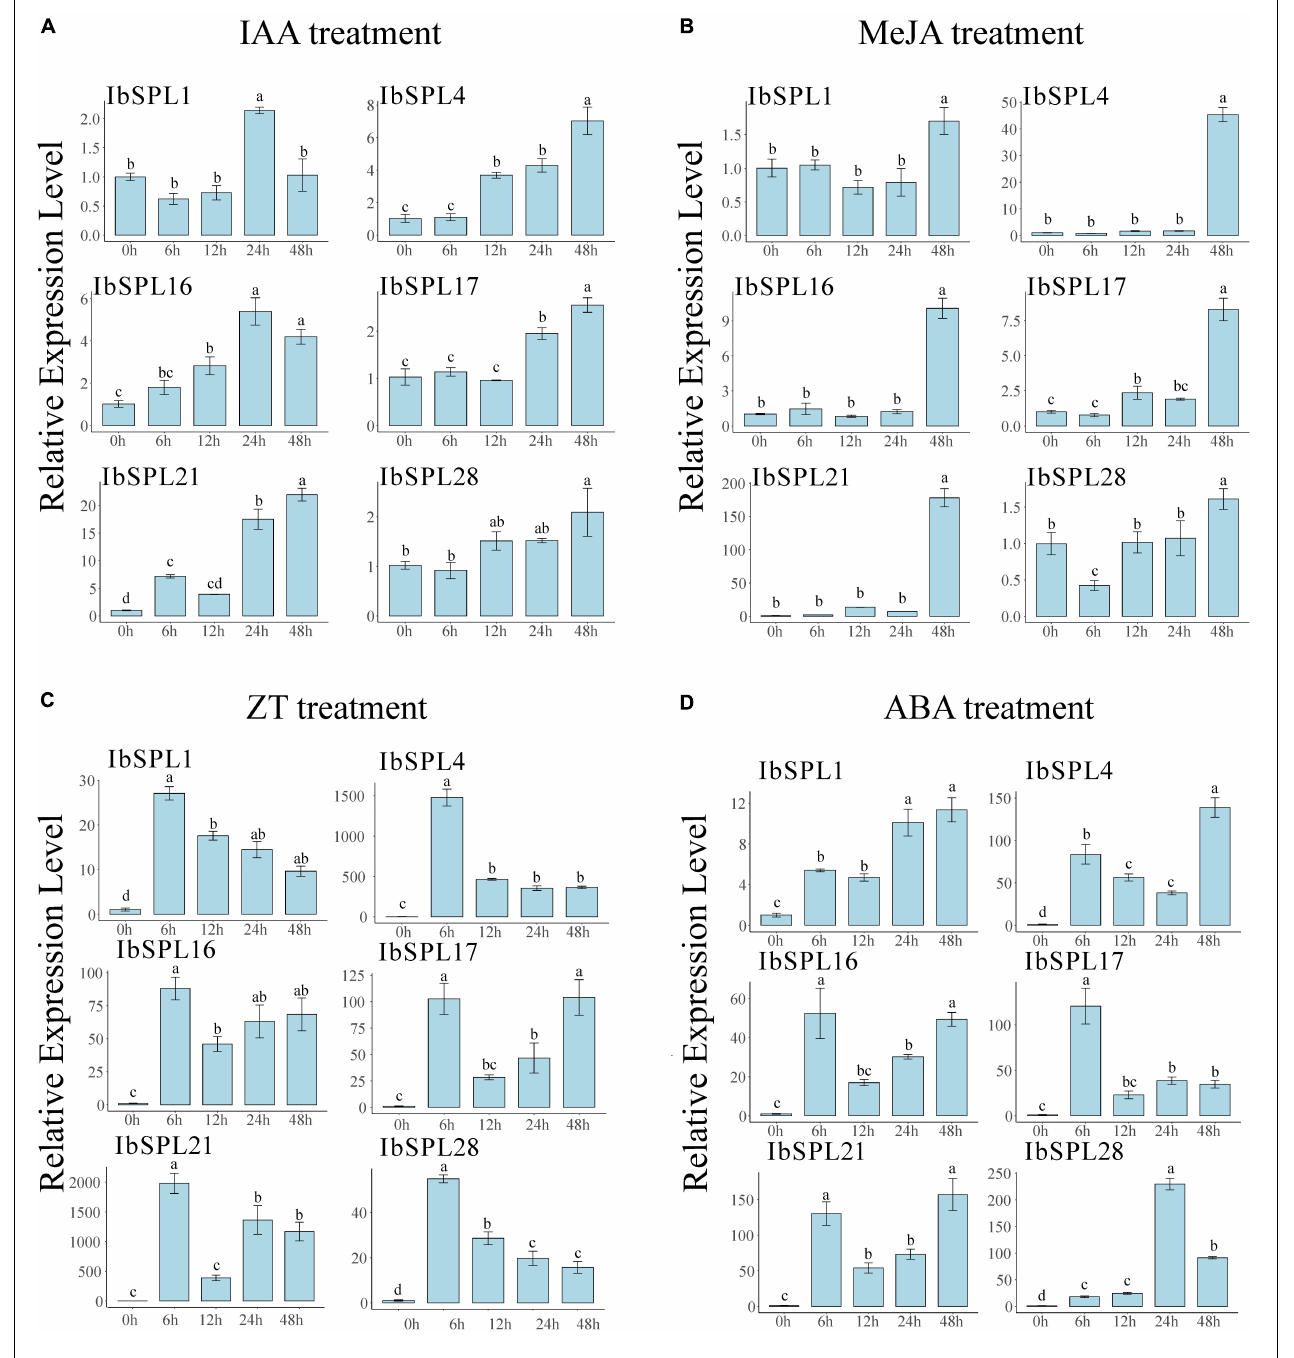
FIGURE 7 | Expression patterns of six IbSPL genes under phytohormone treatment. (A) Expression patterns of the six IbSPL genes under IAA treatment. (B) Expression patterns of the six IbSPL genes under MeJA treatment. (C) Expression patterns of the six IbSPL genes under ZT treatment. (D) Expression patterns of the six IbSPL genes under ABA treatment. Samples were collected at 0, 6, 12, 24, and 48 h after treatment. The x -axis indicates different samples, while the y -axis represents the relative expression calculated using the 2 − (cid:49)(cid:49) CT method. The error bars indicate the standard deviations of the three biological replicates. Different letters indicate statistically significant differences at p <